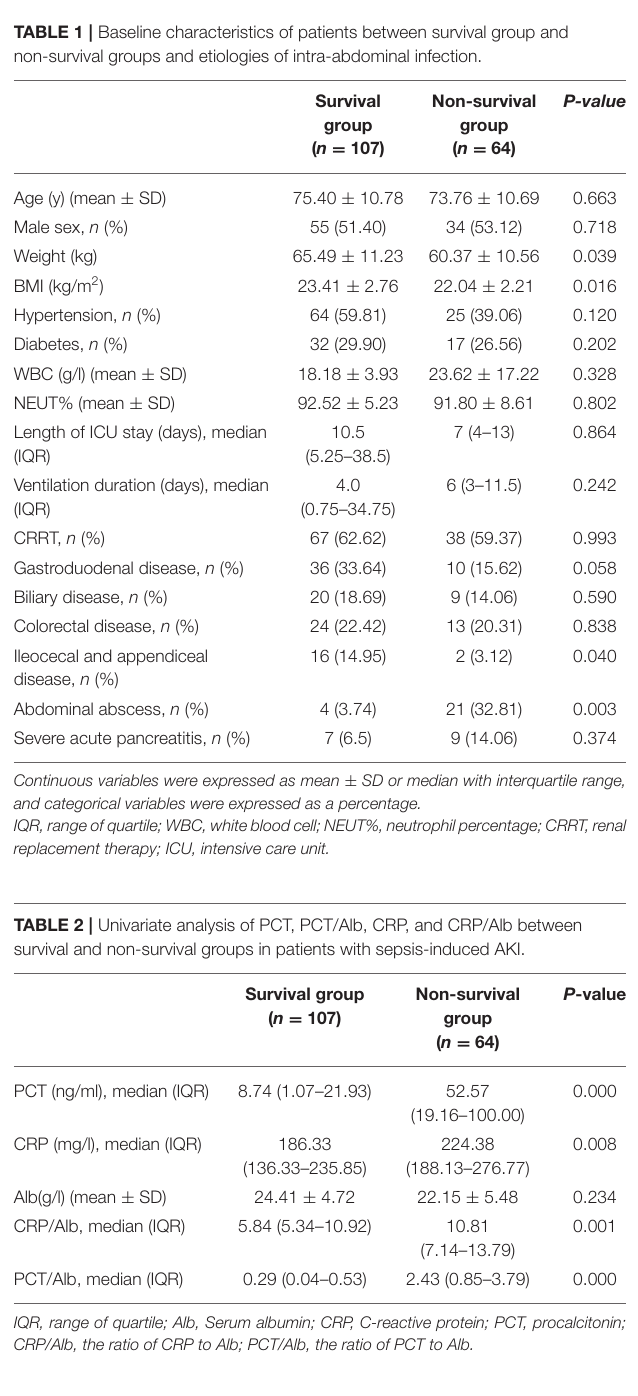
TABLE 1 | Baseline characteristics of patients between survival group and non-survival groups and etiologies of intra-abdominal infection.